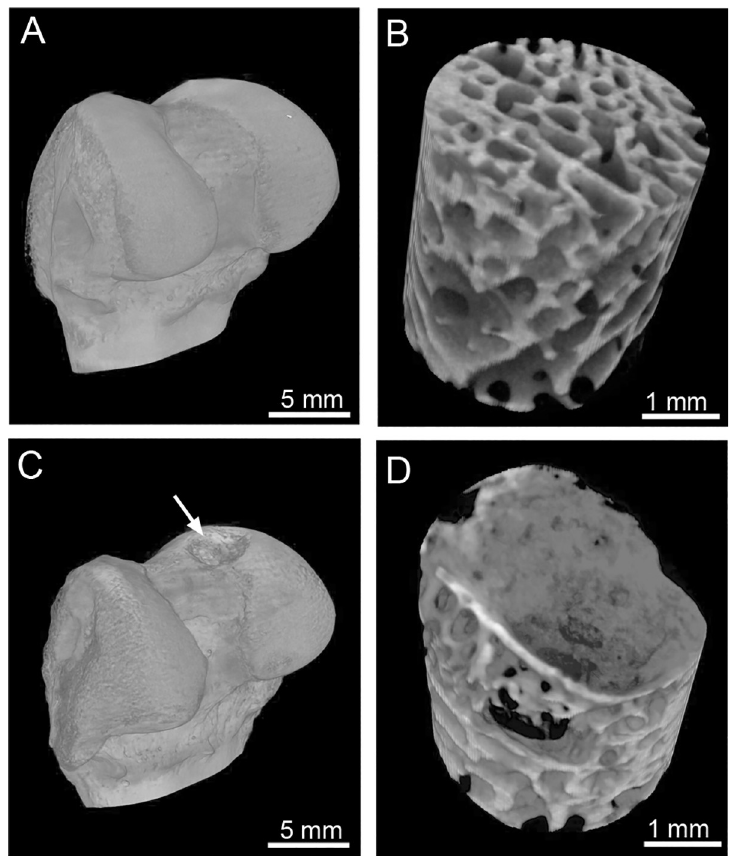
Fig 1. Representative computer tomography images of the uninjured (A) and injured (C, arrow) bones. Panels B (uninjured bone) and D (injured bone) indicate subchondral bone regions analyzed here to determine the extent of mineralization in the injured area (C&D).